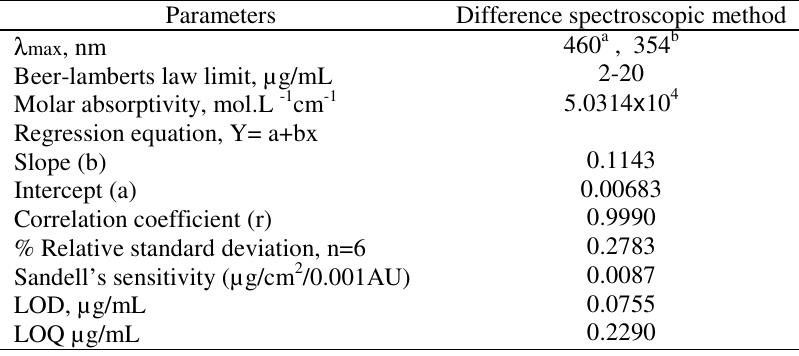
Table 1. Optical characteristics of balsalazide by difference spectroscopy.